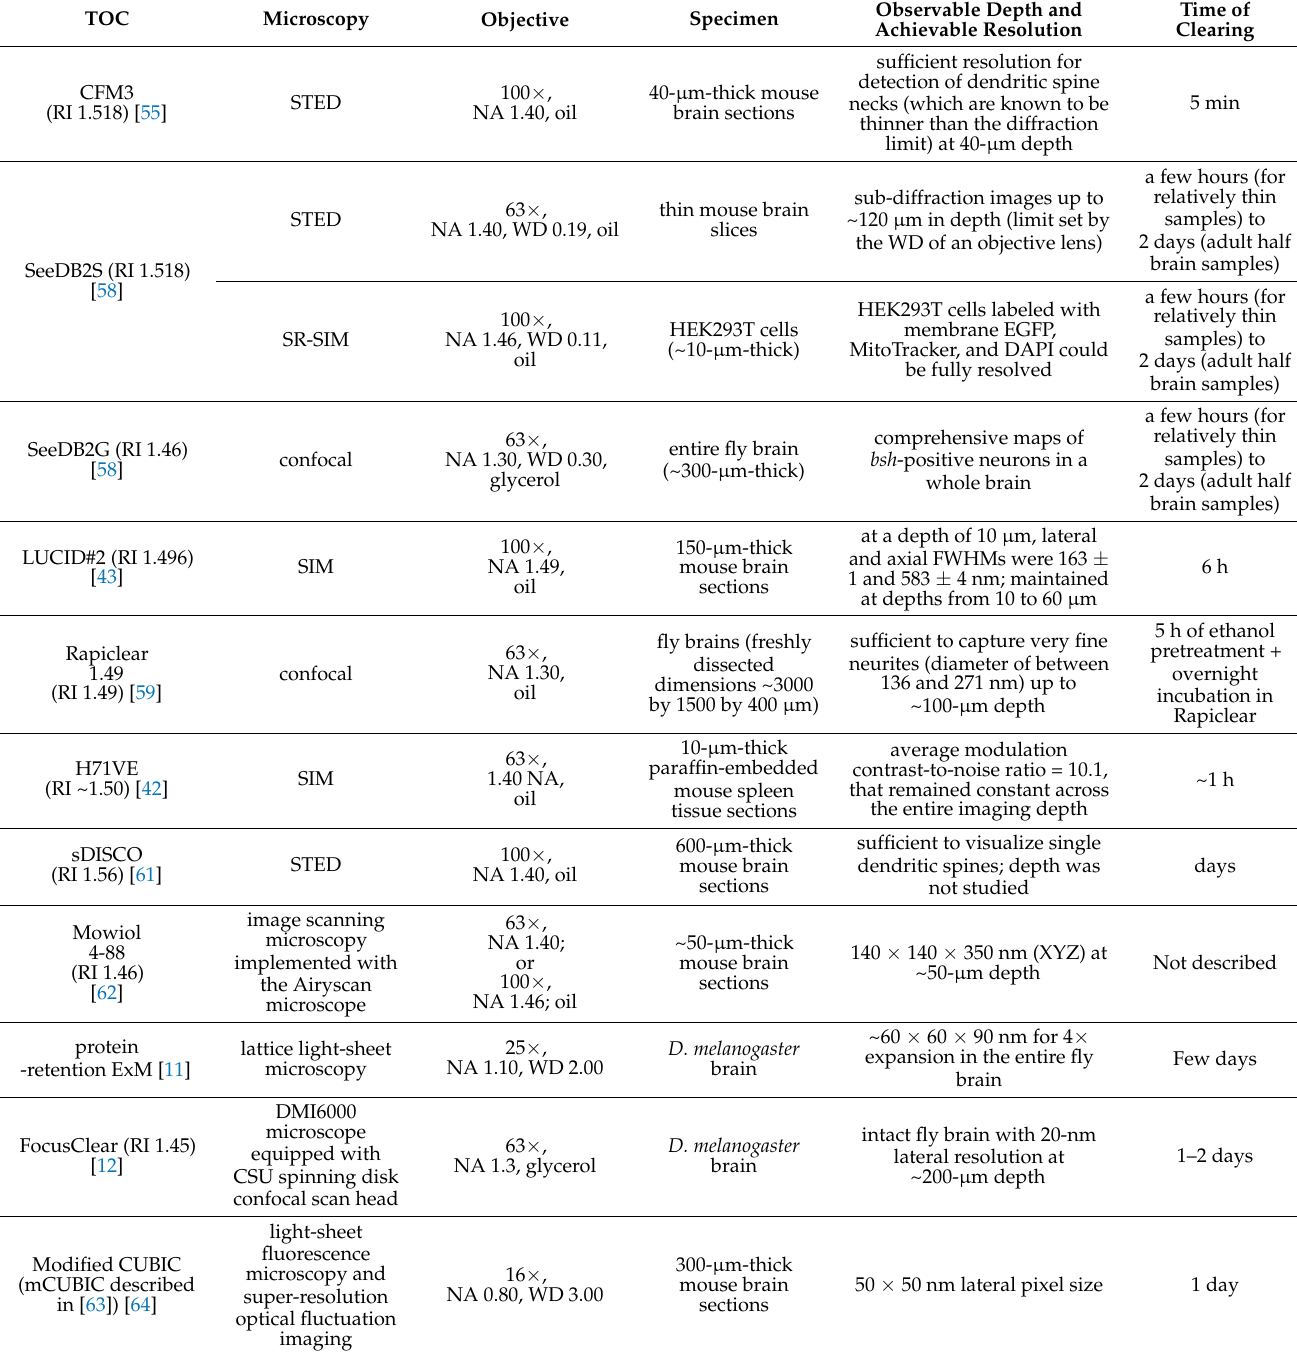
Table 2. Summary of biomedical studies in which TOC and SRM methods were already combined.